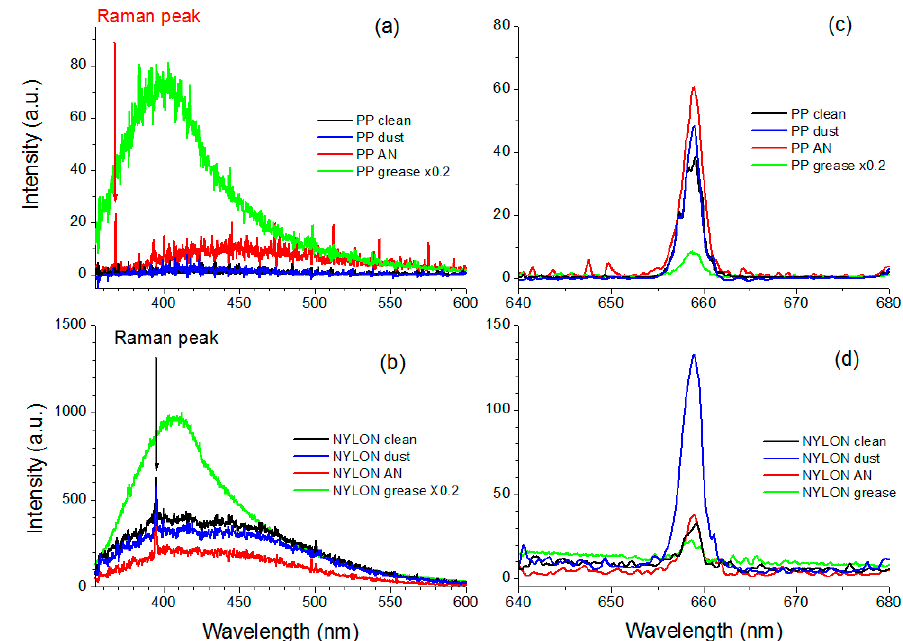
Figure 5. LIF spectra from polypropylene (PP) ( a ) and nylon ( b ) measured on clean area and on fingerprints containing ammonium-nitrate (AN), dust, or grease. The corresponding LS peaks are shown in the right panels ( c , d ).